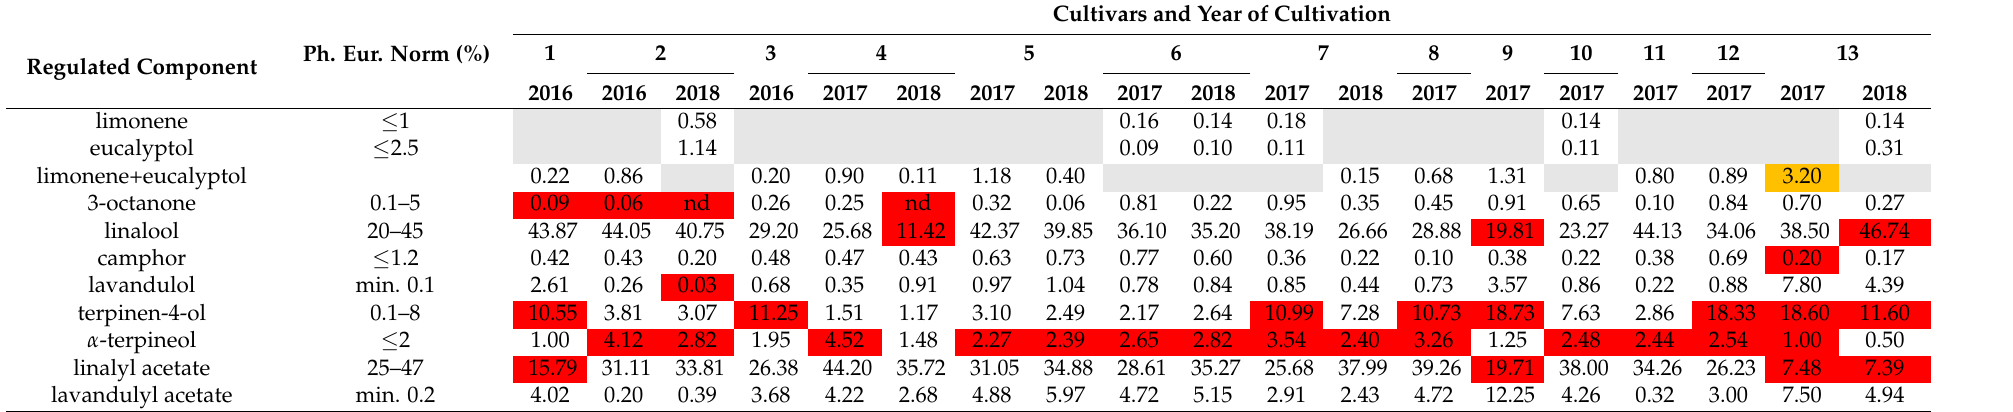
Table 5. Comparative table with % relative abundancies and normative content values given by Ph. Eur 9.